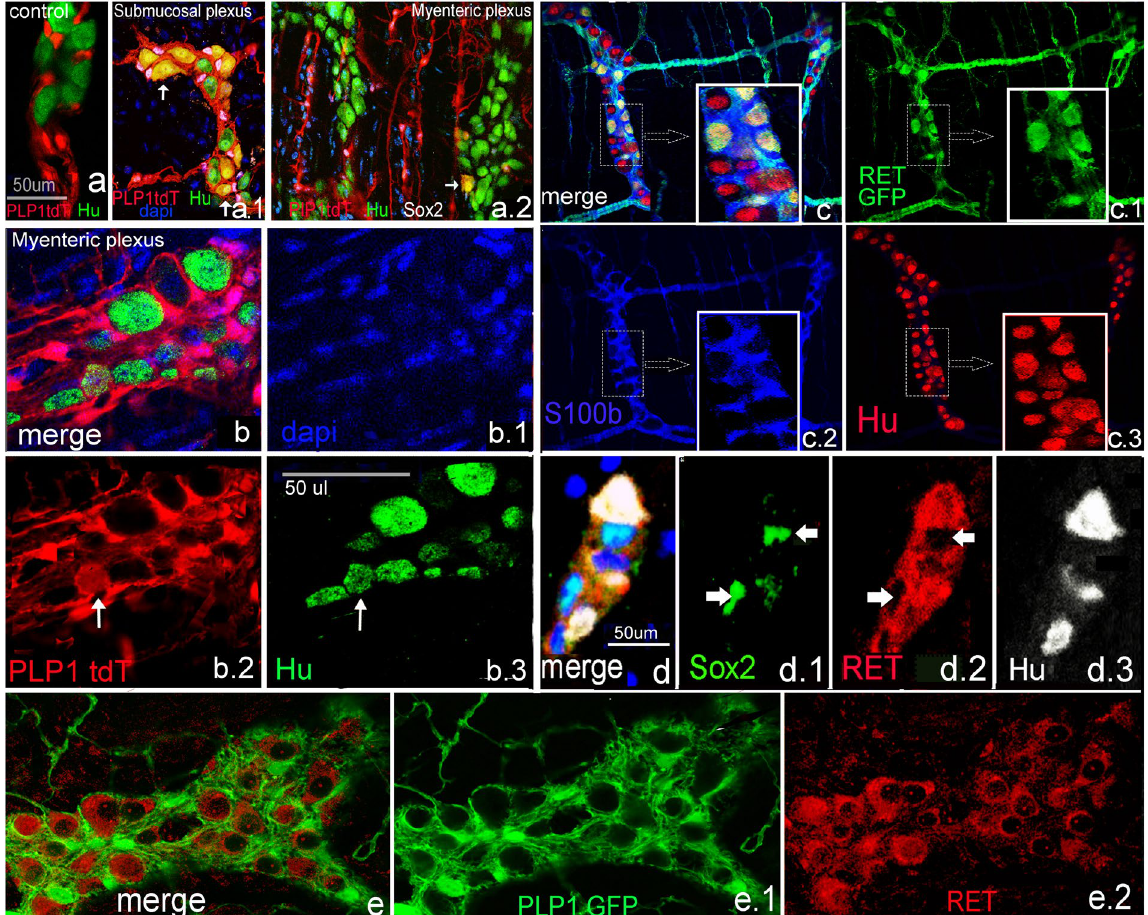
Figure 7. PLP1 + enteric glia give rise to neurons after colitis. PLP1CreER:tdT is not normally expressed in neurons in adult mice ( a ). However, mice give rise to Hu + neurons following colitis in the submucosal ( a .1) and myenteric plexus ( a.2 , b–b.3 , arrows point to PLP1tdT + Hu + cells). In normal, non-inflamed colon, glial cells do not express RET, which is normally expressed by neurons and progenitors ( c – c.3 ). Similarly, Sox2 + cells do not co-express RET in the adult ENS ( d , arrows), nor do PLP1 + cells ( e – e2 ). (Images 7. a , and 7. c were taken at 200x except for closeups, 7. b – e were taken at